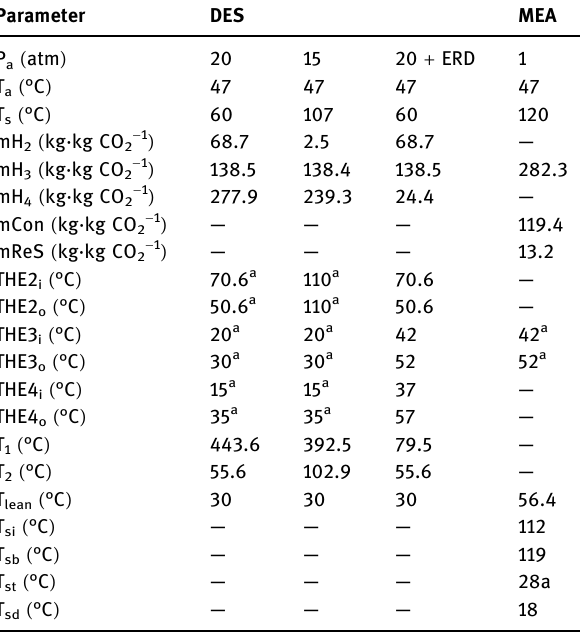
Table A4: Design and operating condition from the process in